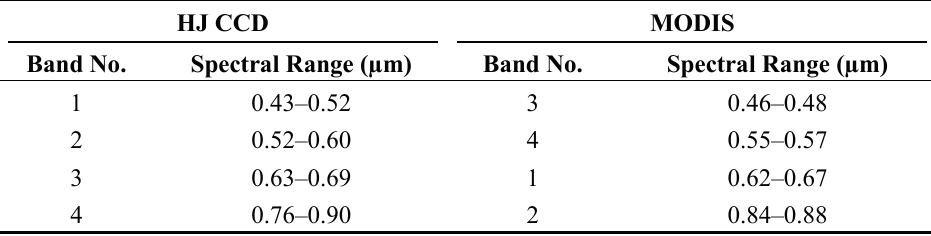
Table 1. Spectral bands (0.4–0.9 µm) of HJ CCD cameras and MODIS.